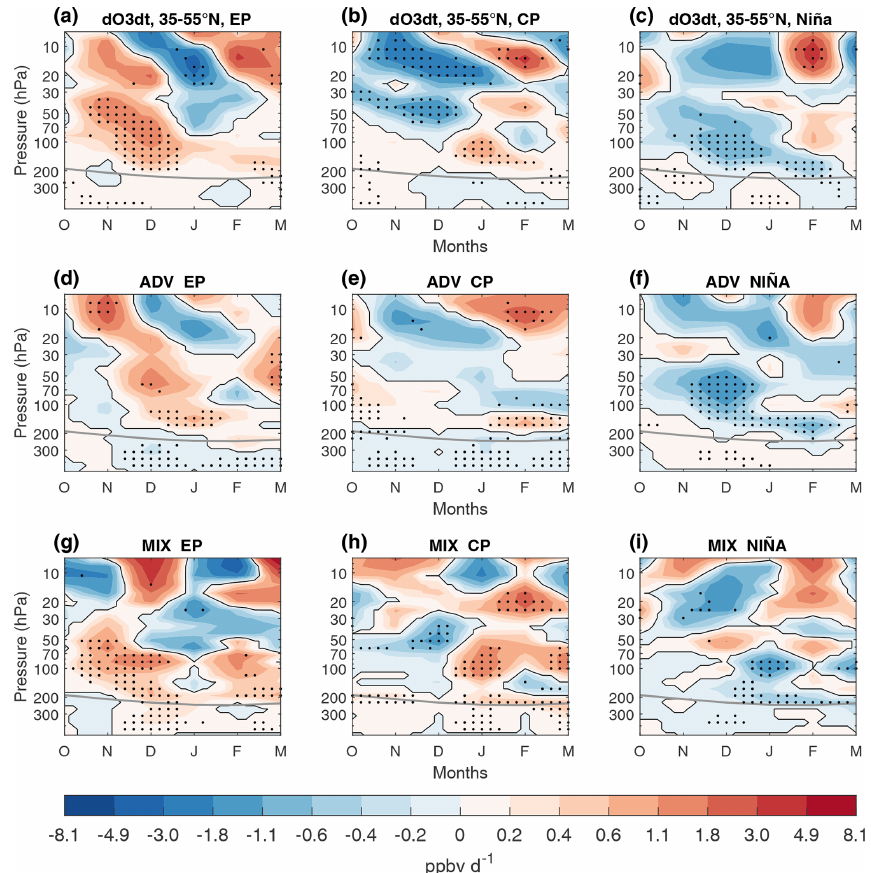
Figure 5. As in Fig. 4 but averaged over 35–55 ◦ N and for anomalies in DO3dt (a–c) ; ADV (d–f) ; and MIX (g–i) , which represents changes related to